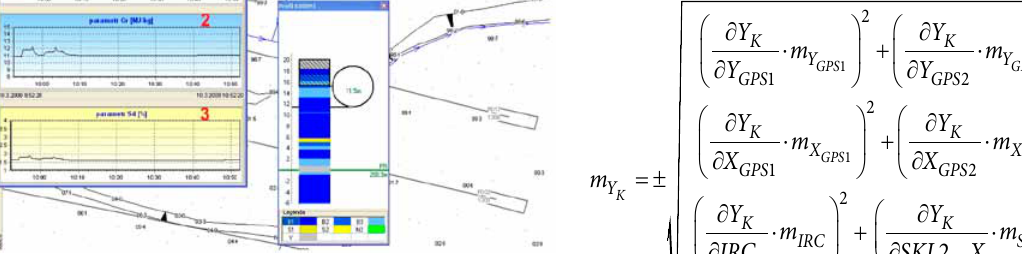
Fig. 4. Elevation of bucket wheel and qualitative parameters of the coal (left part of the figure)